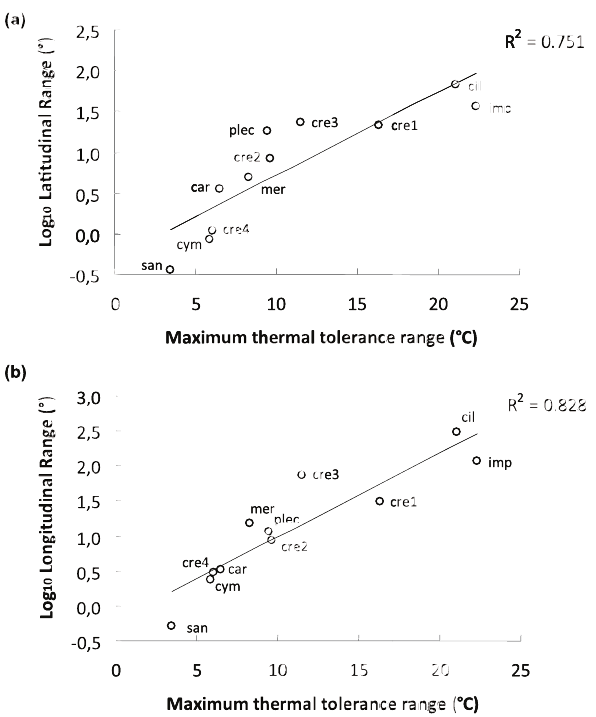
Figure 4. Correlation between maximum thermal tolerance range ( 6 C) and log-transformed latitudinal range (A), and log- transformed longitudinal range (B). The correlation coefficient (R 2 ) is shown for each case. Symbols represent individual species’ as follows: Dictyota cf. caribaea (car), Dictyota ciliolata (cil), Dictyota crenulata # 1 (cre1), Dictyota crenulata # 2 (cre2), Dictyota crenulata # 3 (cre3), Dictyota crenulata # 4 (cre4), Dictyota cymatophila (cym), Dictyota implexa (imp), Dictyota mertensii (mer), Dictyota sandvicensis (san).